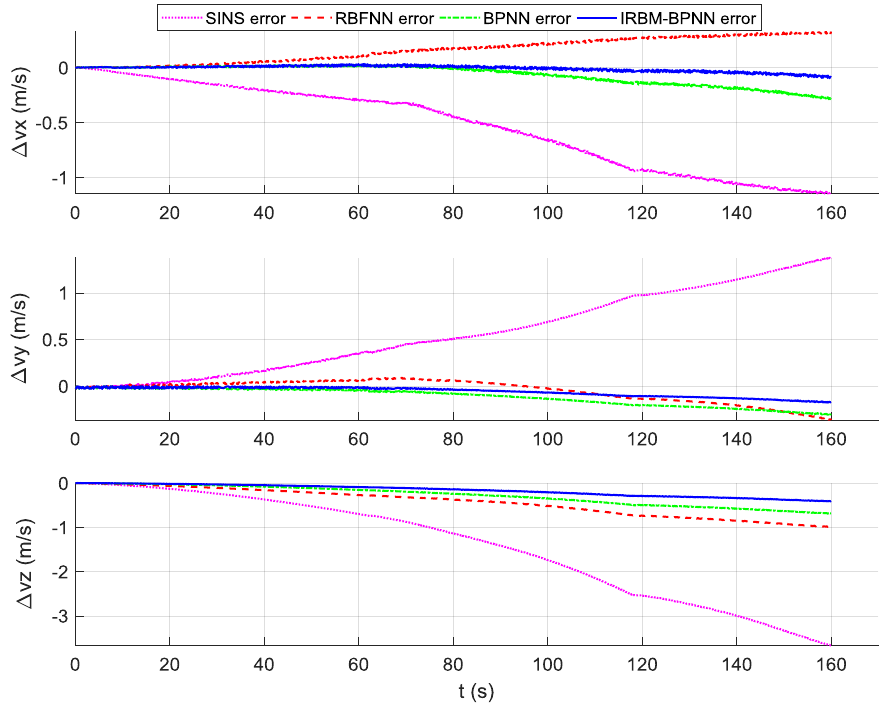
Figure 17. Contrast results of velocity error using three methods.